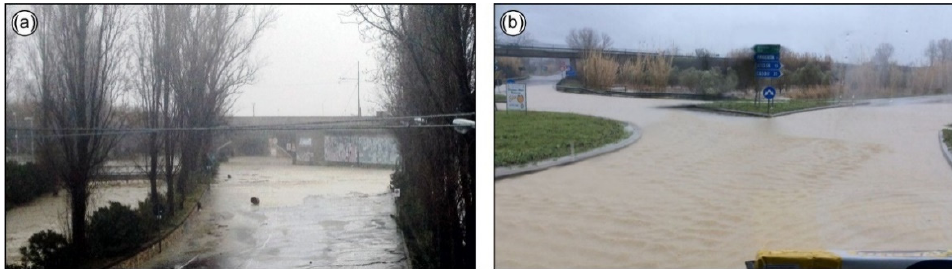
Figure 6. ( a ) Daily rainfall of February–March 2015; ( b ) hourly and cumulative rainfall of 4–6 March 2015 in the S. Vito–C.le Capuano gauge; ( c ) hourly and cumulative rainfall of March 2015 event in the S. Vito–C.le Capuano gauge, the hydrographic level of the Feltrino S. (Feltrino–S. Vito gauge; for the Figure 7. Some effects of the 2015 heavy rainfall event: ( a ) Feltrino Stream flooded out of the banks in its terminal part and mouth area, and flooded a parking area [91]; ( b ) flooded roads [92].